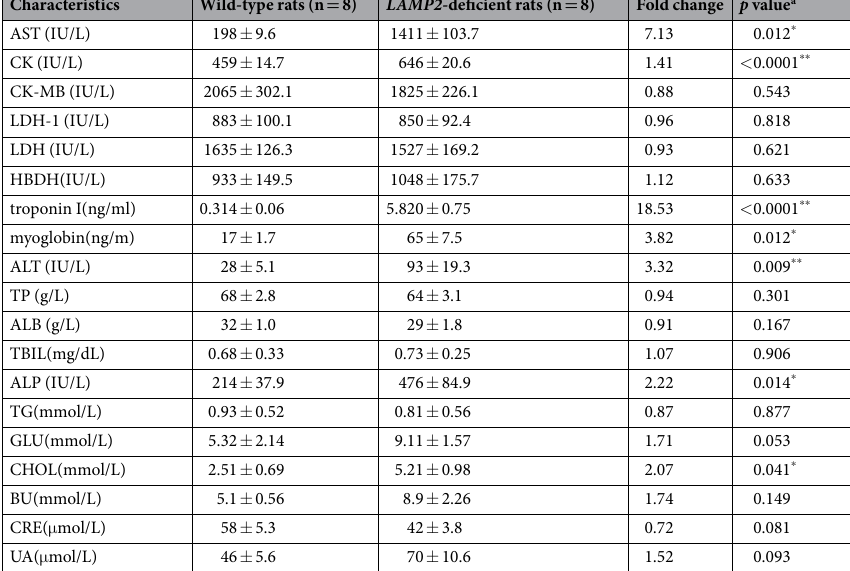
Table 1. Biochemical characteristics of wild-type rats and Lamp2y/ − rats at 8 weeks (n = 8/group). AST, aspartate aminotransferase; CK, creatine kinase; LDH, lactate dehydrogenase; CK-MB, MB isoenzyme of creatine kinase; HBDH, hydroxybutyrate dehydrogenase; ALT, alanine aminotransferase; TP, total protein; ALB, albumin; TBIL, total bilirubin; ALP, alkaline phosphatase; BU, blood urea; CRE, creatinine; UA, Uric acid. a Student’s t-test for two groups. Mean ± SEM. * P < 0.05; ** P <